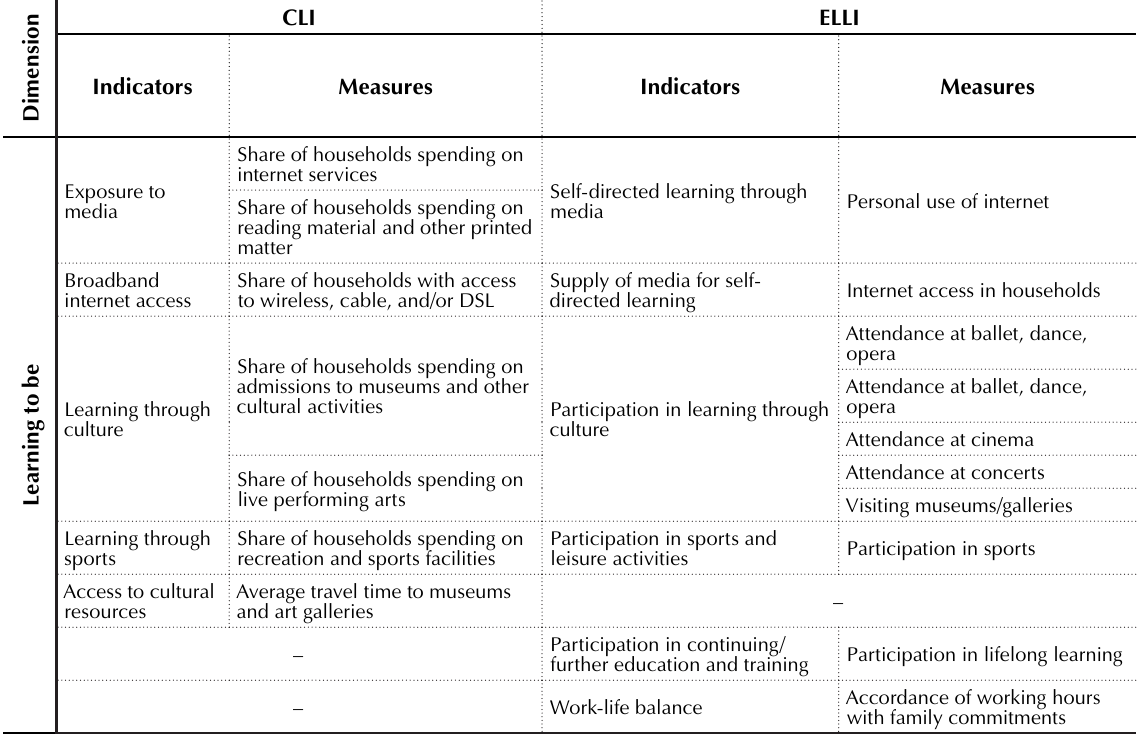
Table A4. The dimension of learning to be Source: Developed by the authors on the basis of the 2010 Composite Learning Index (2010) and Hoskins, Cartwright, and Schoof